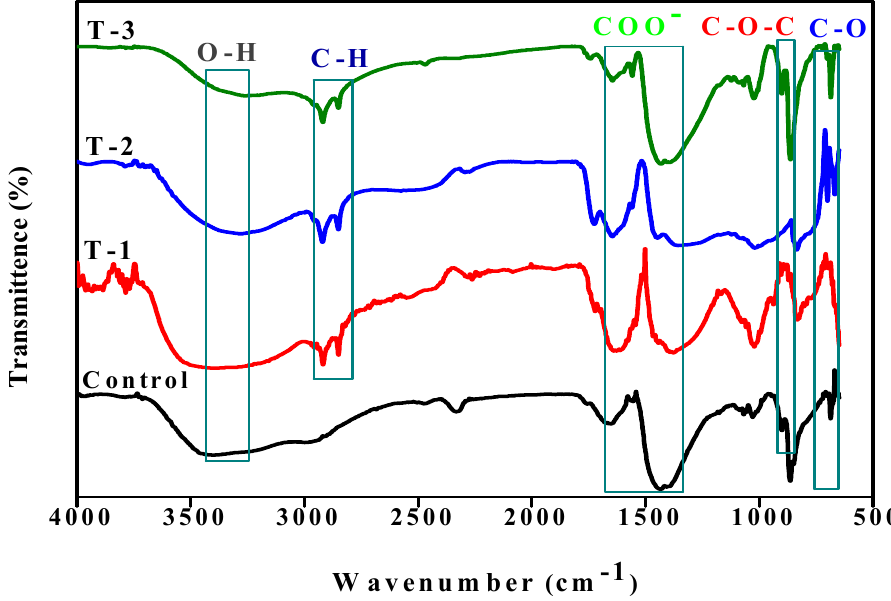
Figure 1. FTIR analysis of control; T-1: (SA:SE 70:30); T-2: (SA:SE 80:20); T-3: (SA:SE 90:10) hydrogels.